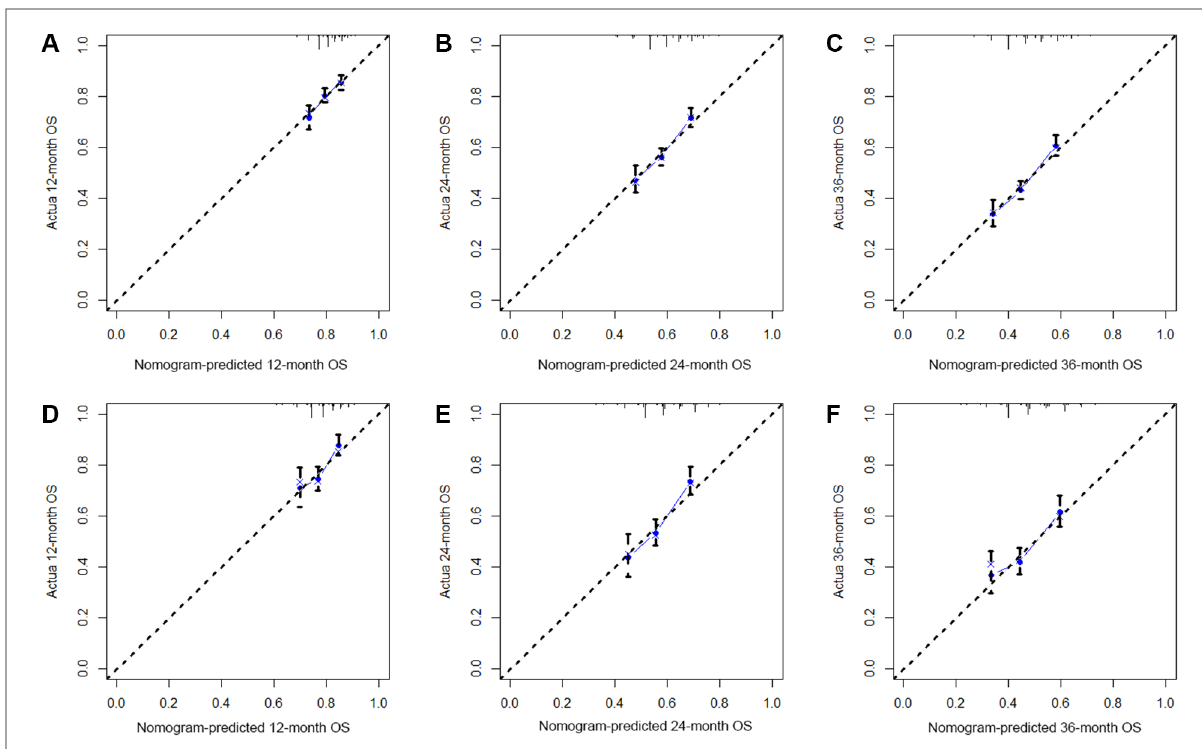
FIGURE 3 The 1-year ( A ), 2-year ( B ) and 3-year ( C ) calibration curves of the nomogram prediction model for predicting overall survival of esophageal cancer patients receiving neoadjuvant chemotherapy in the training cohort and the 1-year ( D ), 2-year ( E ) and 3-year ( F ) calibration curves in the validation